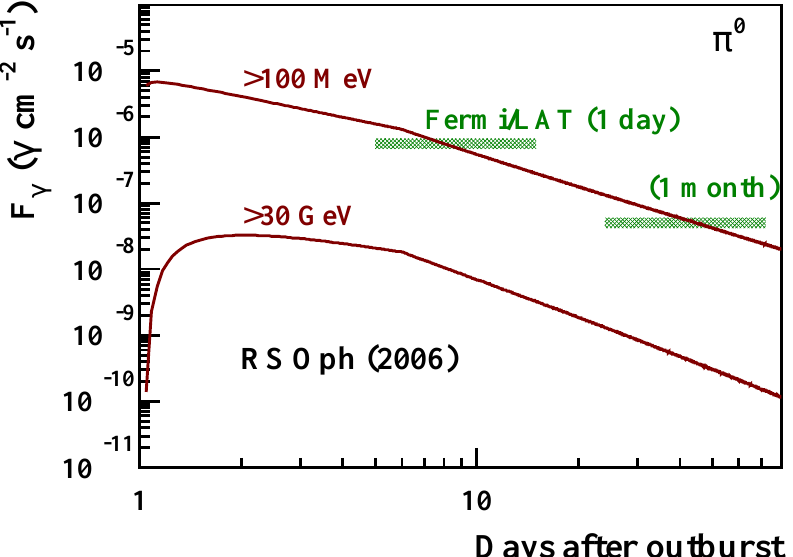
Fig. 4. High energy (cid:13) -ray light curves expected for RS Oph (2006), as compared with Fermi/LAT sensitivities for E (cid:13) > 100